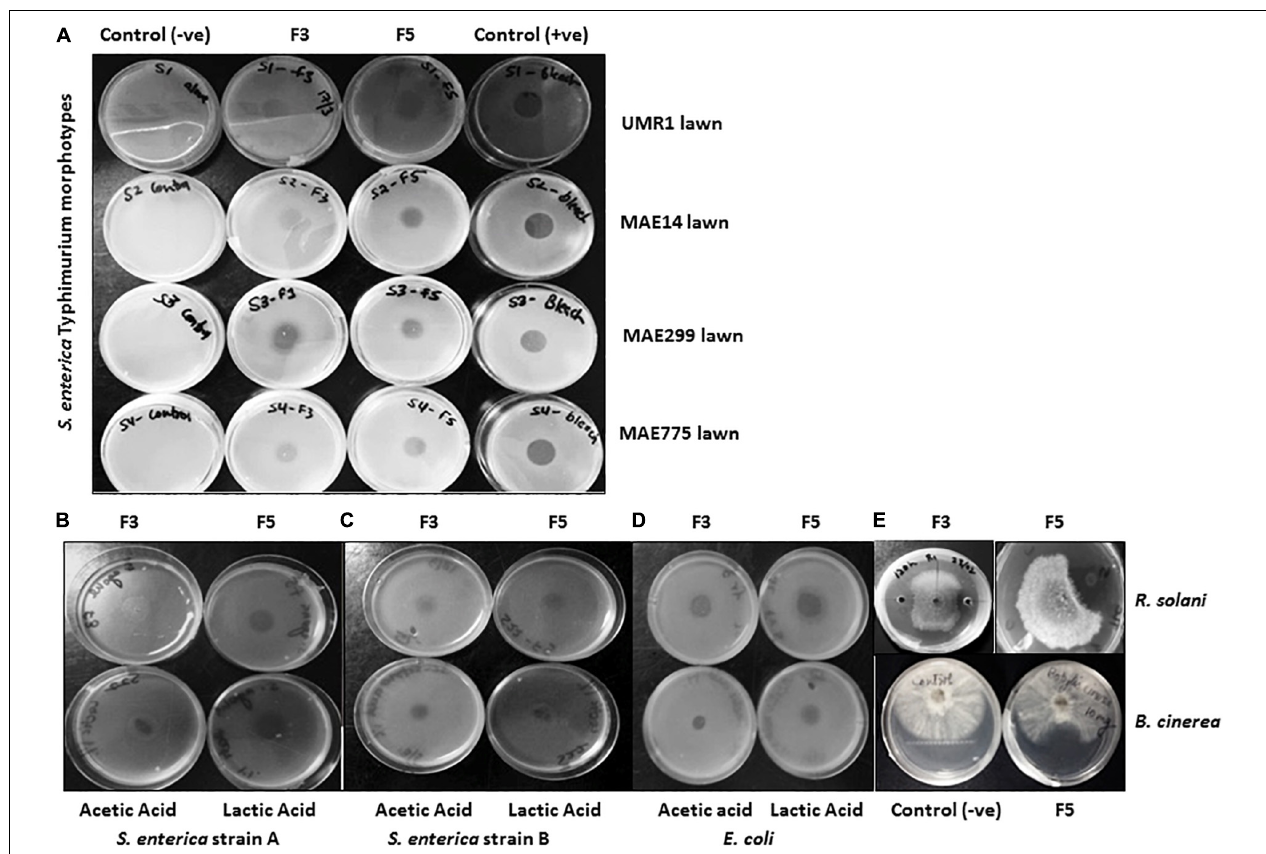
FIGURE 4 | Antimicrobial assessment of APF extracts from B. methylotrophicus OB9. (A) Antimicrobial activity of APF fractions F3 and F5 with the agar diffusion assay against four biofilm morphotypes of S. enterica Typhimurium. From left to right: column 1 contains negative controls (–ve) for growth of each of the four strains (rows 1–4 are UMR1, MAE14, MAE299 and MAE775, respectively); columns 2–4 contain the same strains, but assayed against fraction 3 (F3), fraction 5 (F5) or bleach as positive control (+ve), respectively. Additional diffusion assays of F3, F5, 1% (v/v) acetic acid, and 1% (v/v) lactic acid against S. enterica Agona PARC#5, S. enterica serovar I:Rough-O:e,h:e,n and E. coli E14-6 are depicted in (B–D) , respectively. (E) The antagonistic effect of F3 and F5 against Rhizoctonia solani is depicted in the top two panels, while the bottom two panels display negative control growth ( − ) and APF fraction 5 (F5) assayed against Botrytis cinerea . Antimicrobial assessment of APF was conducted three